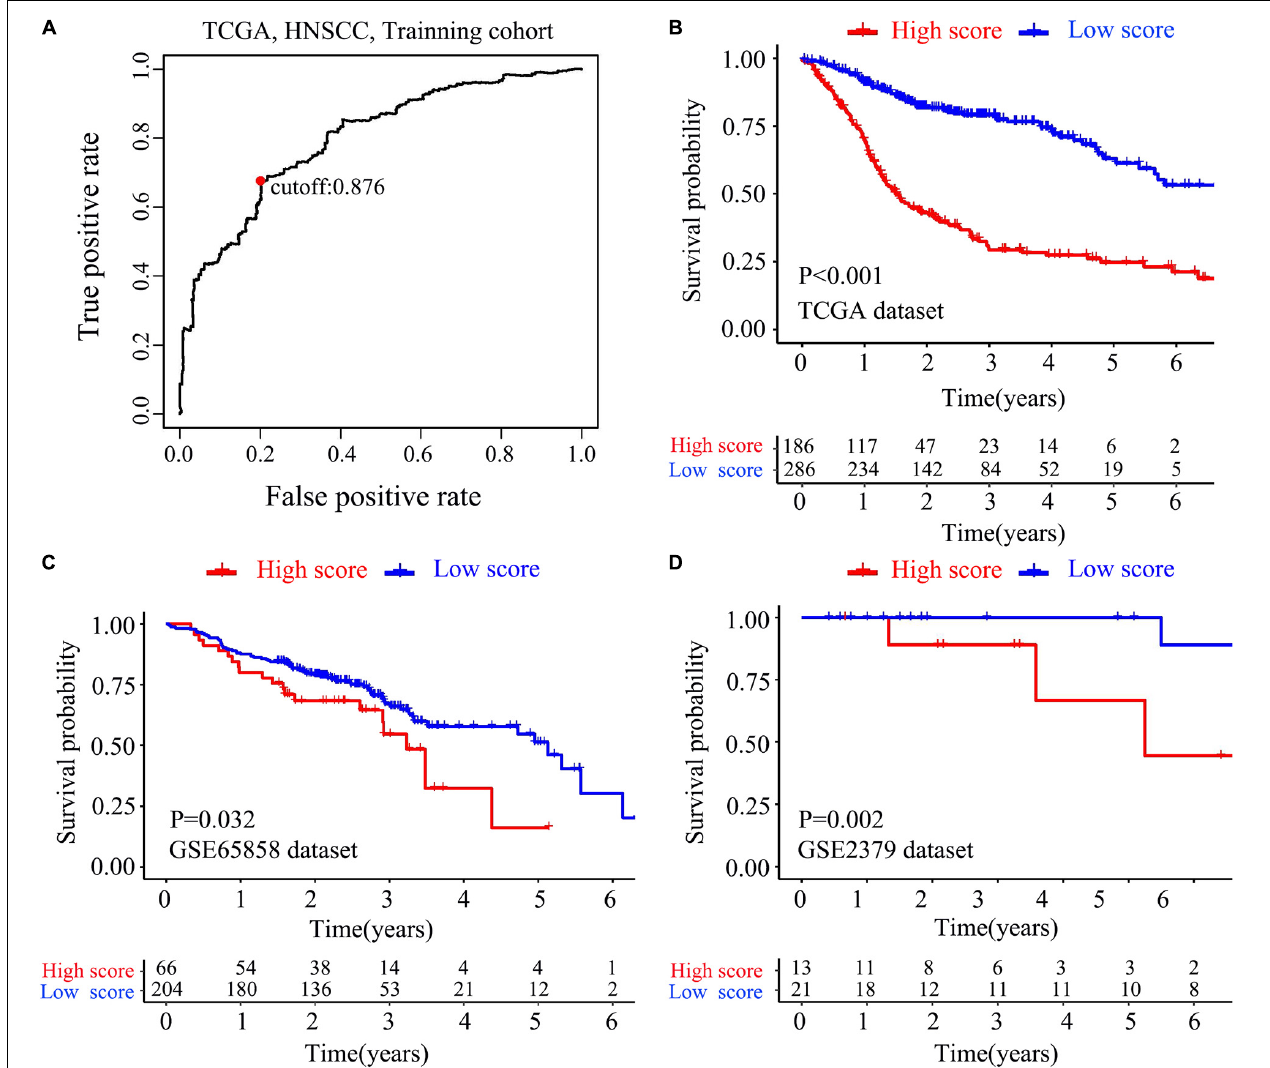
FIGURE 2 | Construction and verification of IRGPs signature. (A) ROC curve analysis was used to get the best cut-off value of the score to divided patients into high score group or low score group. Kaplan-Meier survival curves assessed the effect between high score group and low score group in the TCGA dataset (B) , validated in GSE65858 (C) dataset and GSE22379 dataset (D) ( P <